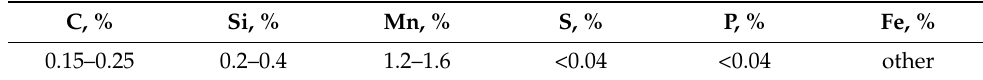
Table 1. Chemical composition of steel